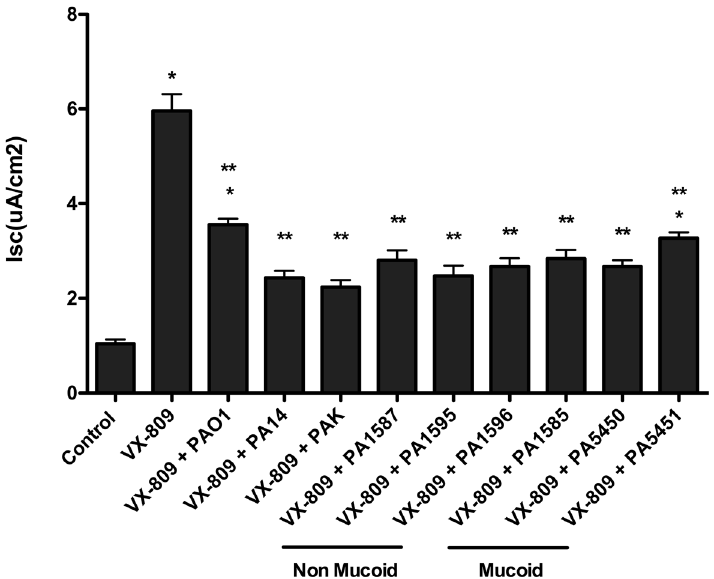
Fig 3. Effects of VX-809 alone and in combination with P . aeruginosa on primary CF-HBE cells. VX-809 (3 μ M, 48 hours.) increased Cl secretion compared to vehicle treated control in primary cultures of CF-HBE cells. PA01, PA14, PAK and 6 clinical isolates of P . aeruginosa reduced VX-809-stimulated F508del-CFTR Cl secretion compared to VX-809 alone. * P < 0.05 versus control. ** P < 0.05 versus VX-809. N = 3 donors, from each donor 3 to 19 monolayers of cells were studied/treatment.